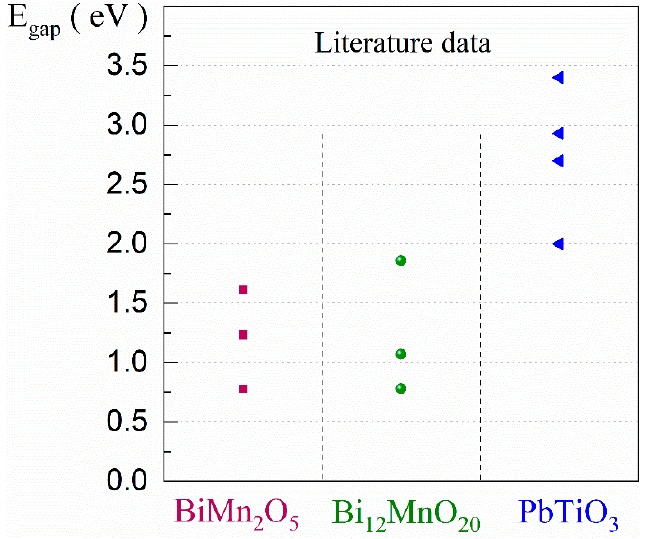
Figure 13. The diagram compares E gap magnitudes, available from cited literature reports for BiMn 2 O 5 , Bi 12 MnO 20, and PbTiO 3. BiMn 2 O 5 , Bi 12 MnO 20, and PbTiO 3